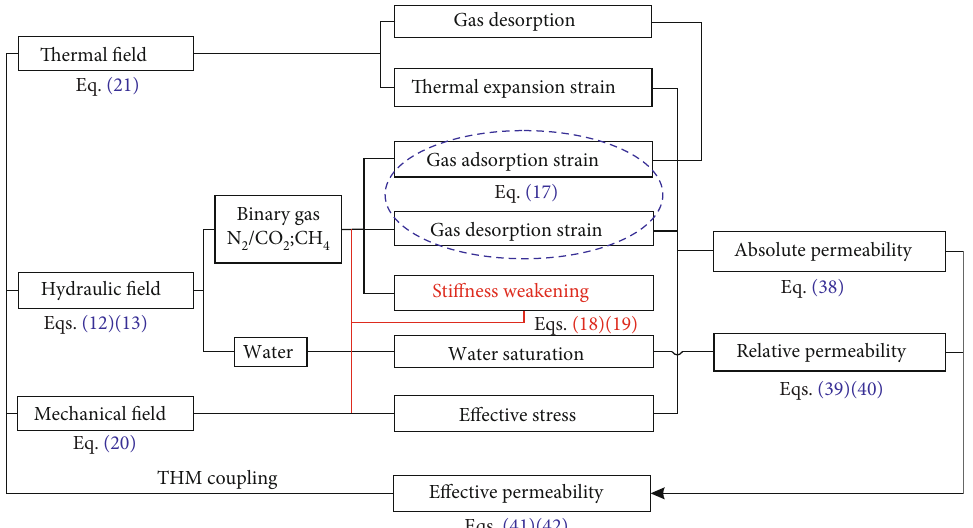
Figure 2: Interactions of multiple processes during ECBM